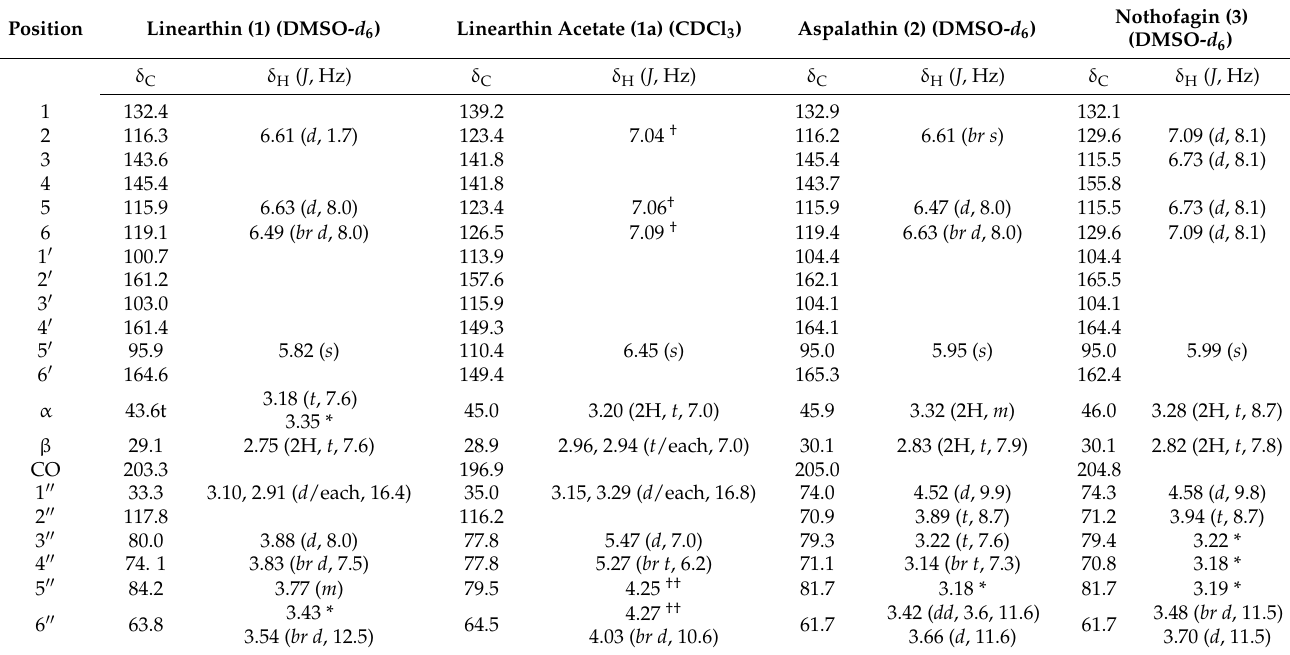
extra cyclic ether.